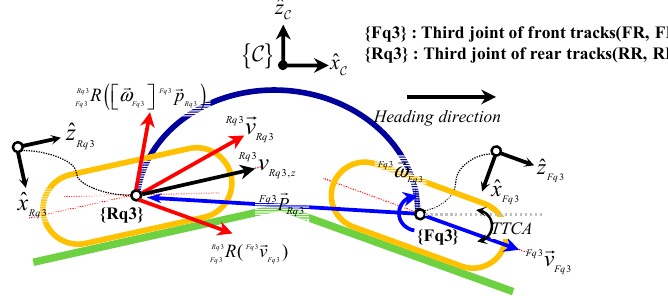
Figure 5. Schematic diagram of backward velocity propagation for calculating the rear driving speed in terms of the front driving speed.